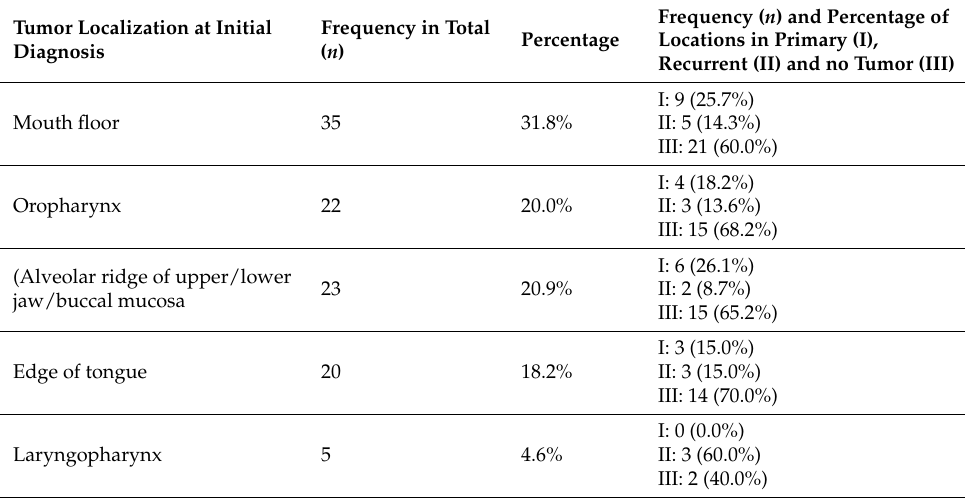
Table 1. Distribution of tumor localizations at initial